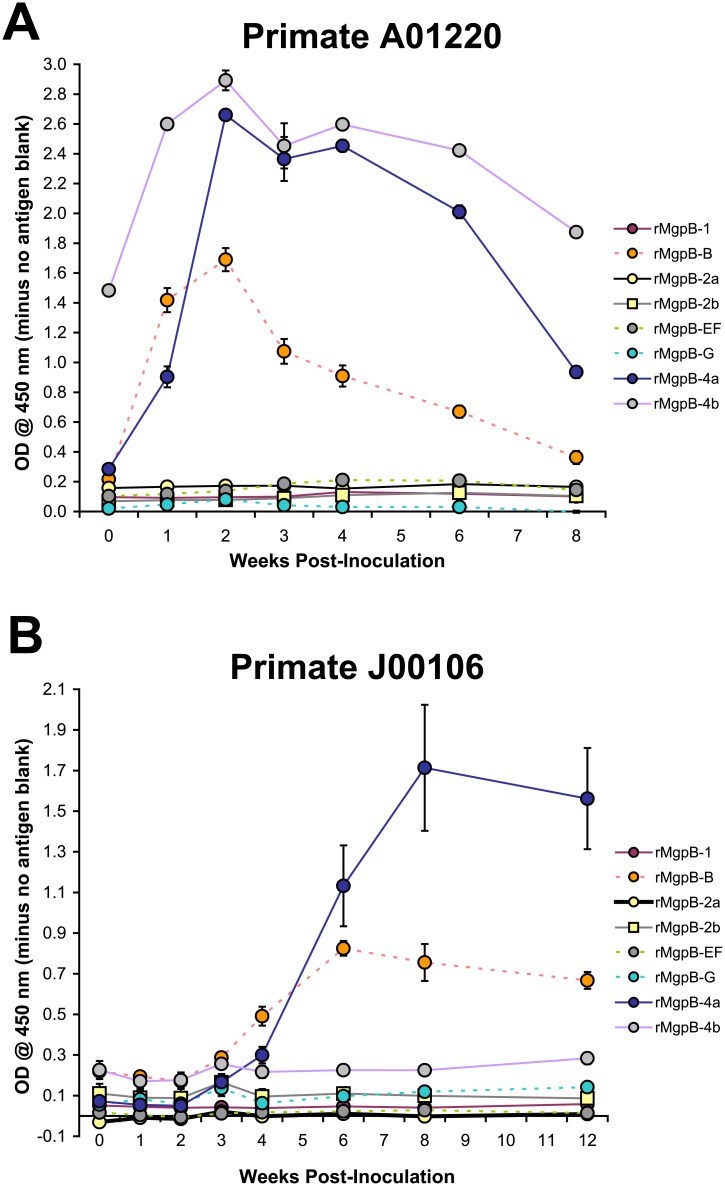
Antibodies Elicited During Persistent Experimental M. genitalium Infection of Non-Human Primates Recognize Variable Region B and the Conserved C-terminus.ELISA reactivity of primate serum collected at weekly time points over the course of infection measured against the recombinant MgpB proteins spanning the conserved (rMgpB-1, -2a, -2b, -4a, and -4b) and variable regions (rMgpB-B,-EF, and-G), as indicated in the legends to the right. ODs shown represent values after subtracting the readings from no antigen control wells. (A) In primate A01220 (cervical and salpingeal pocket infection), antibody reactivity to recombinant proteins spanning the variable rMgpB-B, as well as the proximal and distal conserved C-terminus (rMgpB-4a and -4b), increased during infection, peaking at week 2 post-inoculation. (B) Primate J00106 (cervical infection only) exhibited a similar pattern of reactivity against rMgpB-B and -4a, with the antibody response peaking around 8 weeks post-infection. Data above represents the average of two independent experiments, with each condition tested in triplicate.